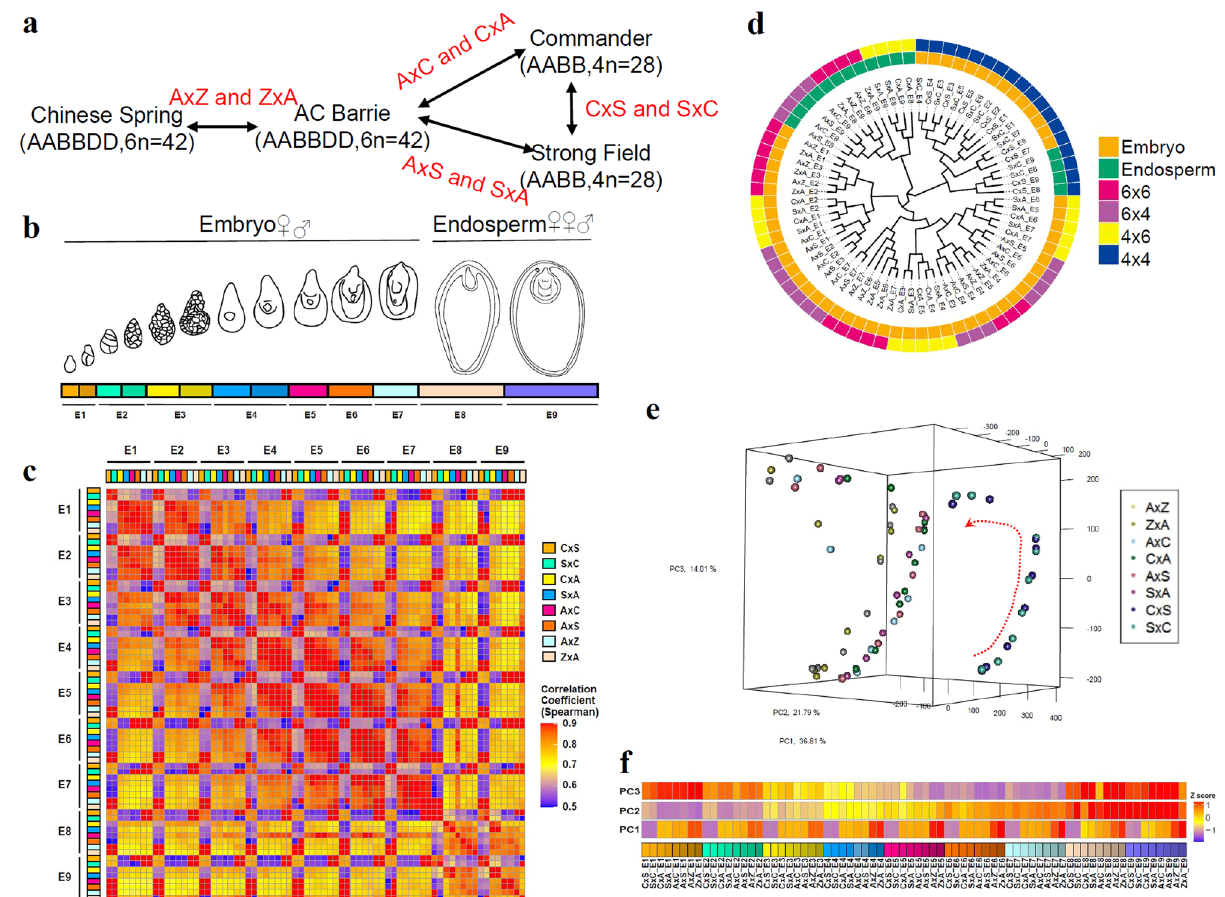
Fig. 1 Transcriptome-wide landscape of gene expression pro fi les during embryogenesis after hybridization between polyploid wheat species. a Experimental design and interspeci fi c hybridizations. Reciprocal crosses were conducted between hexaploids, between hexaploid and tetraploid and between tetraploids. A = AC Barrie; C = Commander; S = Strong Field; Z = Chinese Spring. b Sampling stages of embryo (E1 to E7) and endosperm (E8 and E9) in this study. c Sample correlation matrix of reciprocal samples. Spearman correlation coef fi cients were calculated using normalized counts of all identi fi ed genes. d Phylogenetic tree of all samples. Different tissues (embryo and endosperm) and crosses between different ploidy levels are shown. 6 × 6, cross between hexaploids; 6 × 4, cross between hexaploid and tetraploid using hexaploid as female parent; 4 × 6, cross between tetraploid and hexaploid using tetraploid female parent; 4 × 4, cross between tetraploids. e 3D plot of principal component analysis (PCA) showing the fi rst three principal components (PCs), which together explain 72.6% of the variance. Samples from the same stage cluster together and there is a smooth progression through developmental time (shown as in a red dashed arrow). Samples with different ploidy levels were separated. The amount of variance explained by each PC is indicated on each axis. f Representation of the expression pro fi les that contribute most to the fi rst 3 PCs. The expression values are centered and scaled ( Z -score) for all genes that contribute most to that PC and then the mean value for each sample is plotted. C×S, Commander( ♀ ) × Strong Field( ♂ ); S×C, Strong Field ( ♀ ) × Commander( ♂ ); C×A, Commander( ♀ ) × AC Barrie( ♂ ); A×C, AC Barrie( ♀ ) × Commander( ♂ ); S×A, Strong Field( ♀ ) × AC Barrie( ♂ ); A×S, AC Barrie( ♀ ) × Strong Field( ♂ ); Z×A, Chinese Spring( ♀ ) × AC Barrie( ♂ ); A×Z, AC Barrie( ♀ ) × Chinese Spring( ♂ A phylogenetic tree separated reciprocal samples into two groups (Fig. 1d). Similar to the correlation matrix, hexaploid and pentaploid samples were grouped together, apart from tetraploid samples. Embryo and endosperm samples were also separated. Endosperms of hexaploid and pentaploid samples grouped together and apart from the endosperm tetraploid sample cluster, suggesting that ploidy level differences have a larger effect than tissue differences.